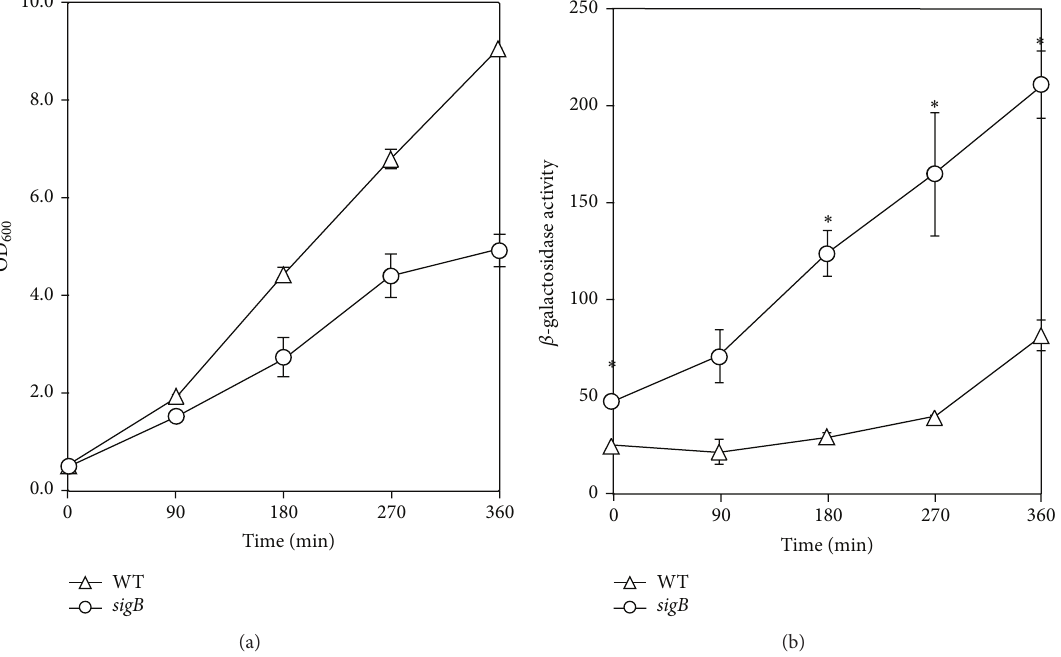
Figure 3: Regulation of msrA1/msrB locus in a methicillin-sensitive S. aureus strain SH1000 by SigB. The msrA1/msrB promoter- lacZ reporter strains were cultured in TSB and growth was measured as OD 600 (a). 𝛽 -galactosidase activity levels were measured in wild-type S. aureus strain SH1000 (open triangles) and its derivative sigB mutant (closed squares) during different stages of growth (b). Values indicate averages of data from at least three independent experiments ± standard error ( ∗ significant at 𝑝 ≤ 0.05 ).